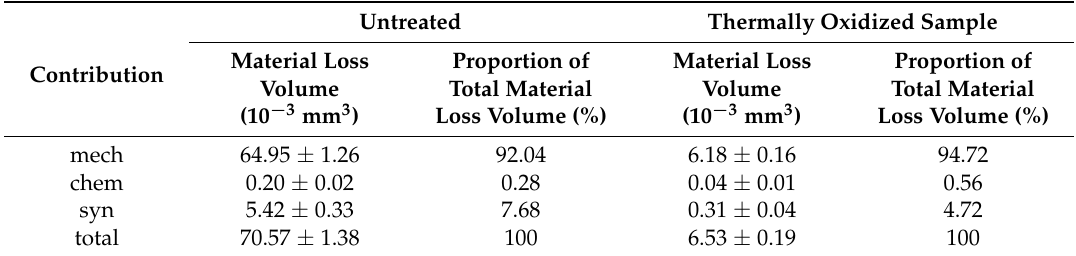
Table 5. Contribution of mechanical wear, corrosion, and synergistic effect to total material loss volume of untreated and thermally oxidized